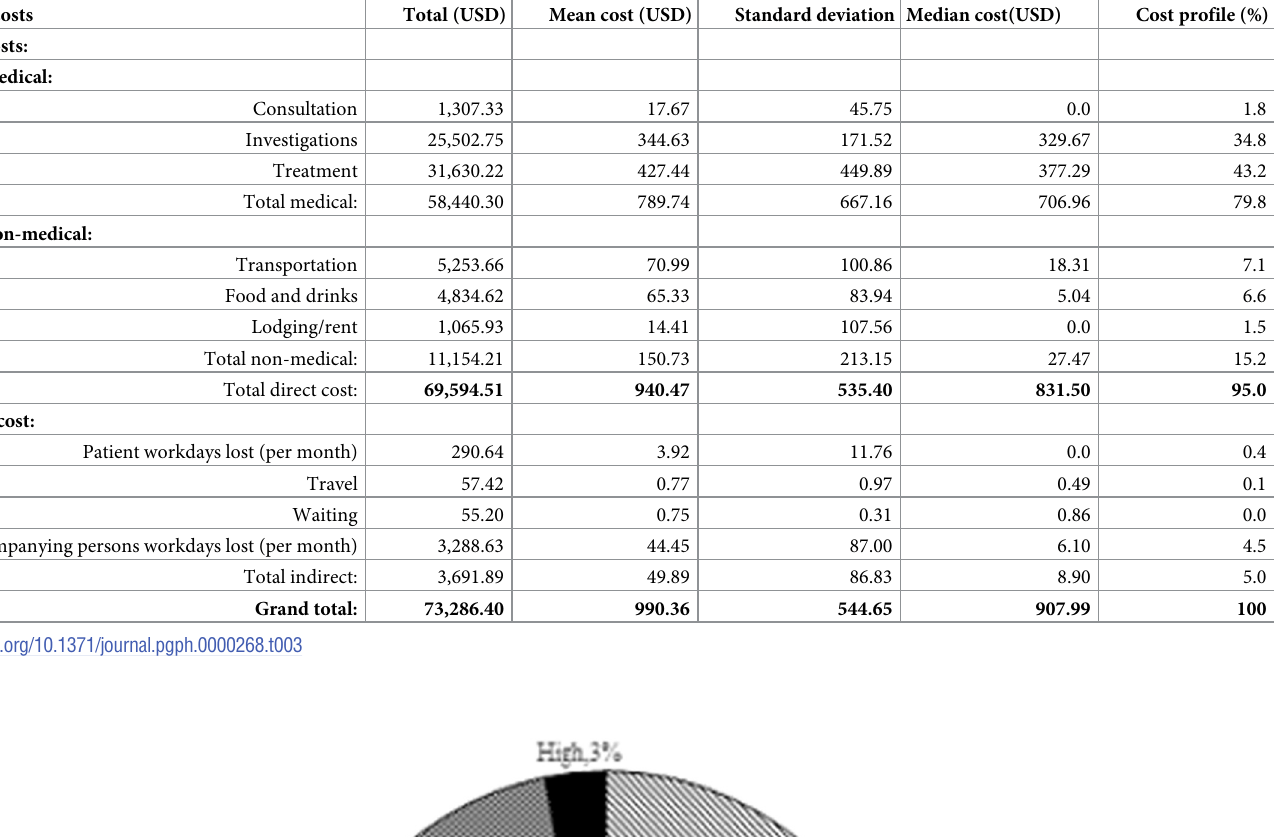
Table 3. Direct and indirect cost.